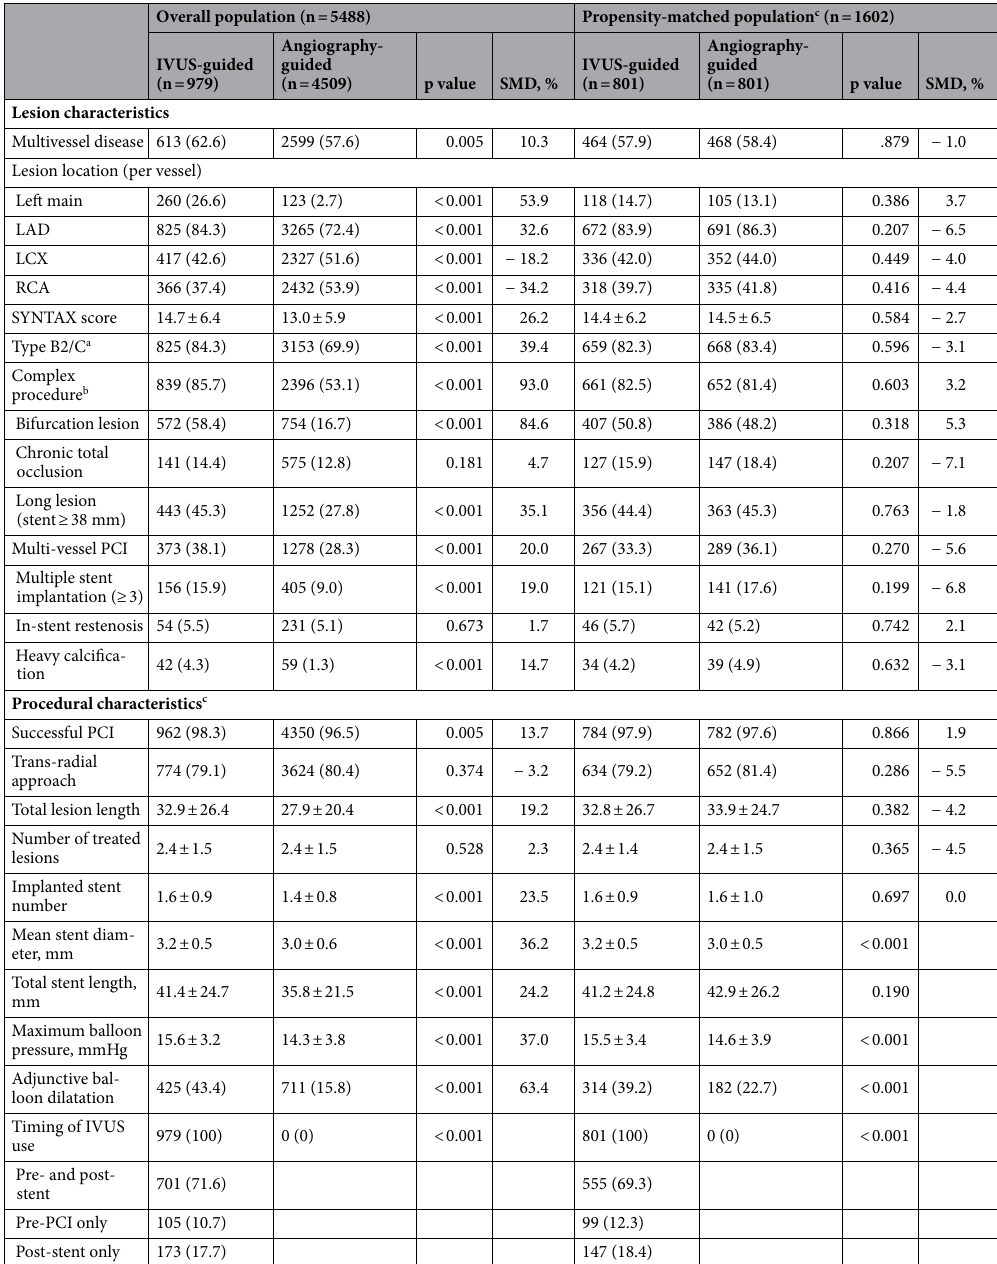
Table 2. Angiographic characteristics according to use of IVUS in overall and propensity-matched populations. ACC, American College of Cardiology; AHA, American Heart Association; IVUS, intravascular ultrasound; LAD, left anterior descending artery; LCX, left circumflex artery; RCA, right coronary artery; SMD, standardized mean difference; SYNTAX, Synergy between PCI with Taxus and Cardiac Surgery. a AHA/ ACC lesion classification. b Complex procedure was defined as bifurcation, chronic total occlusion, left main disease, long lesion, multivessel PCI, multiple stent implantation, in-stent restenosis, or heavily calcified lesion. c Procedural characteristics that might be affected by IVUS use were excluded from the propensity score matched